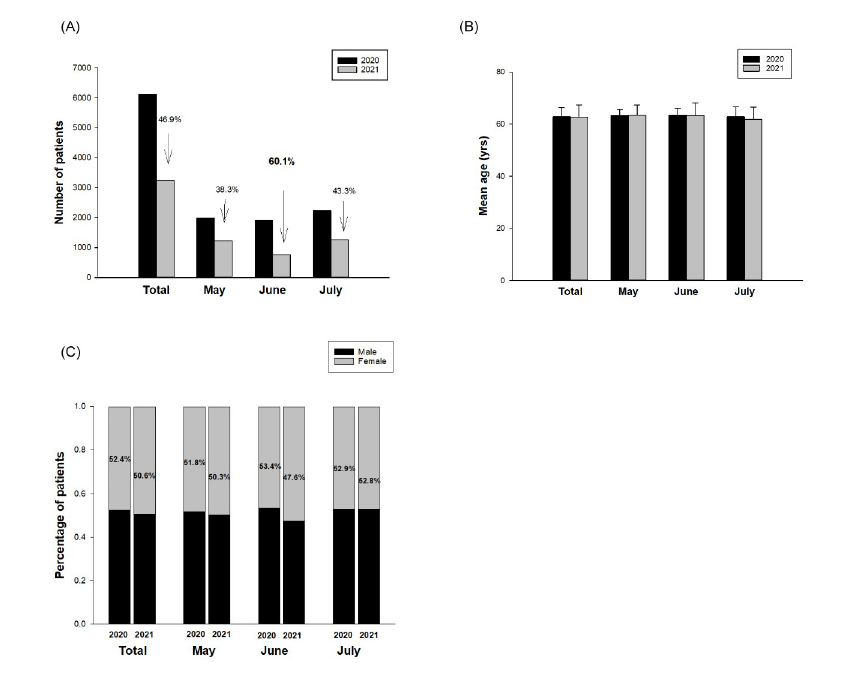
Fig 2. Comparison of (A) number, (B), mean age, and (C) distribution of gender of ophthalmic outpatients during the COVID-19 pandemic period and those of the control group. The mean age and gender distribution during the pandemic period and in individual months (May, June, and July) of 2021 did not differ significantly from those in the same period of